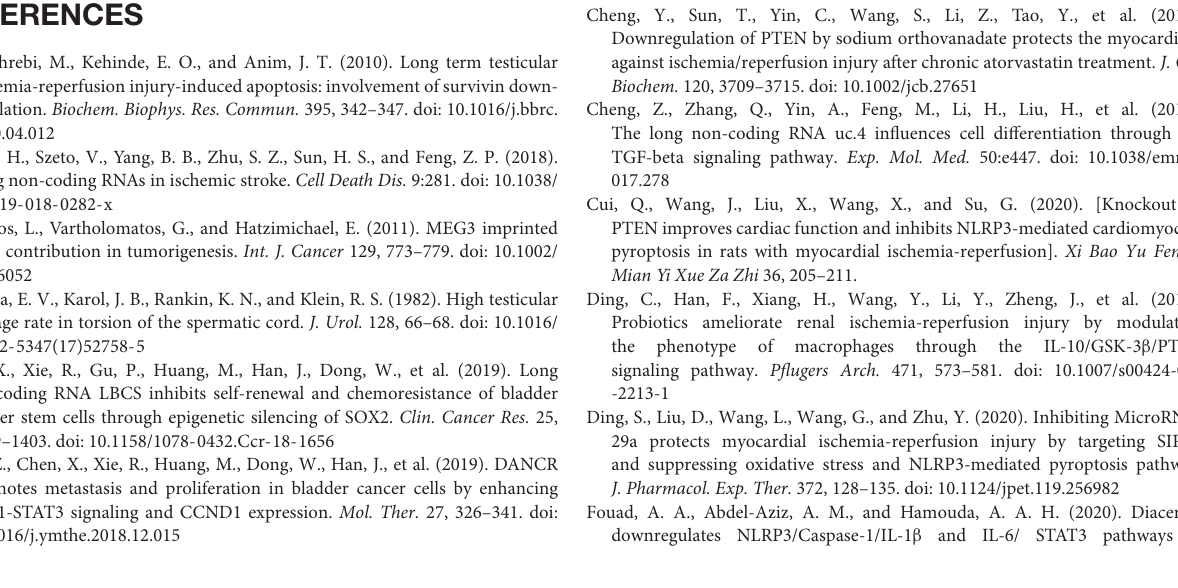
Supplementary Figure 1 | The inhibition of NLRP3 can block the pyroptosis in GC-1 (A) cleaved caspase-1 protein expression in GC-1 cells with MCC950 treatment in normoxia or with 3 h OGD/12 h reoxygenation treatment. *p<0.05 vs cells without MCC950 treatment, n = 6 per group; (B) ELISA analysis was performed to determine the expression of IL-1 β and IL-18 in GC-1 cells with MCC950 treatment in normoxia or with 3 h OGD/12 h reoxygenation